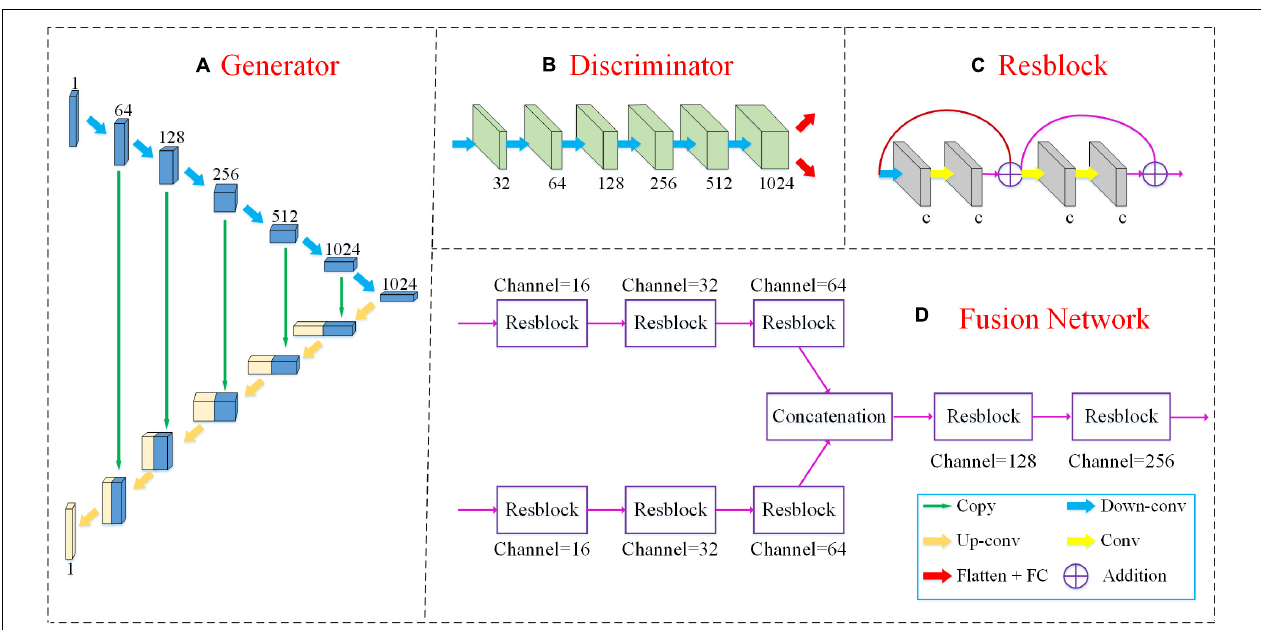
FIGURE 2 | The detailed network structures of our method include a 3D U-Net generator, a discriminator and a multimodal fusion network as shown in panels (A,B,D) . The “Resblock” is the basic unit of the fusion network as shown in panel (C) . The green arrow “copy” implies that the two feature maps are connected along the channel dimension. “Down-conv” and “Up-conv” represent downconvolutional and upconvolutional operations, respectively. Both of them use 3 × 3 × 3 filters applied with a stride of 2. The yellow arrow “Conv” denotes a convolutional layer with 3 × 3 × 3 filters, but the stride is 1. The red arrow “Flatten+FC” indicates that we flatten the feature map into a vector and input it into the FC layer. “Addition” denotes the elementwise addition. TABLE 1 | Demographic and clinical characteristics of the subjects. Paired